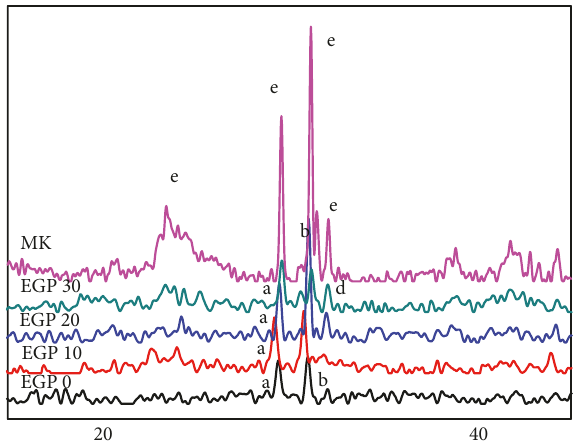
Figure 3: 20 ∘ -40 ∘ XRD patterns of different resin content geopoly- mers and metakaolin.